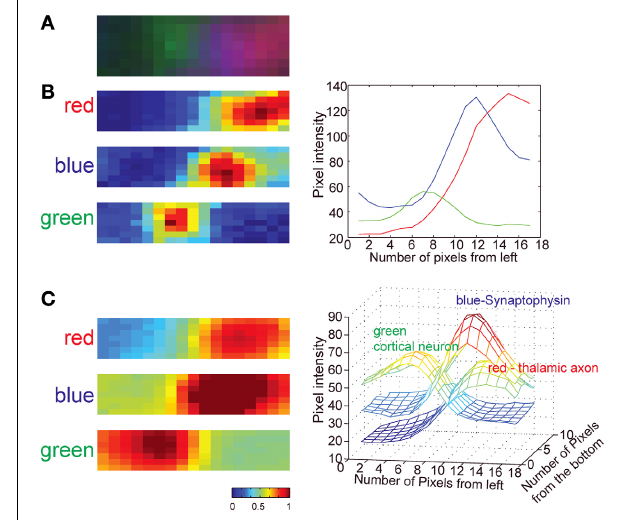
FIGURE 10 | Distribution of GFP, tdTomato and synaptophysin staining at TC synapses. (A) Three-color image of an example TC synapse (image from a single section; green is post-synaptic GFP, red is pre-syanptic tdTomato, blue is pre-synaptic synaptophysin stain). (B) Pixel intensity map for each color channel for the single image shown in (A) (left) and the plot of pixel intensity averaged across all pixels vertically (right). (C) Pixel intensity map for each color channel averaged for 30 TC synapses. Individual images of synapses were first aligned based on PSDs of the correlative EM images and then cumulative signal intensity calculated. Note that the synaptophysin signal is skewed toward the presynaptic membrane whereas the tdTomato signal is not. Images shown are ∼ 1 . 1 × 0 . 4 µ m 2